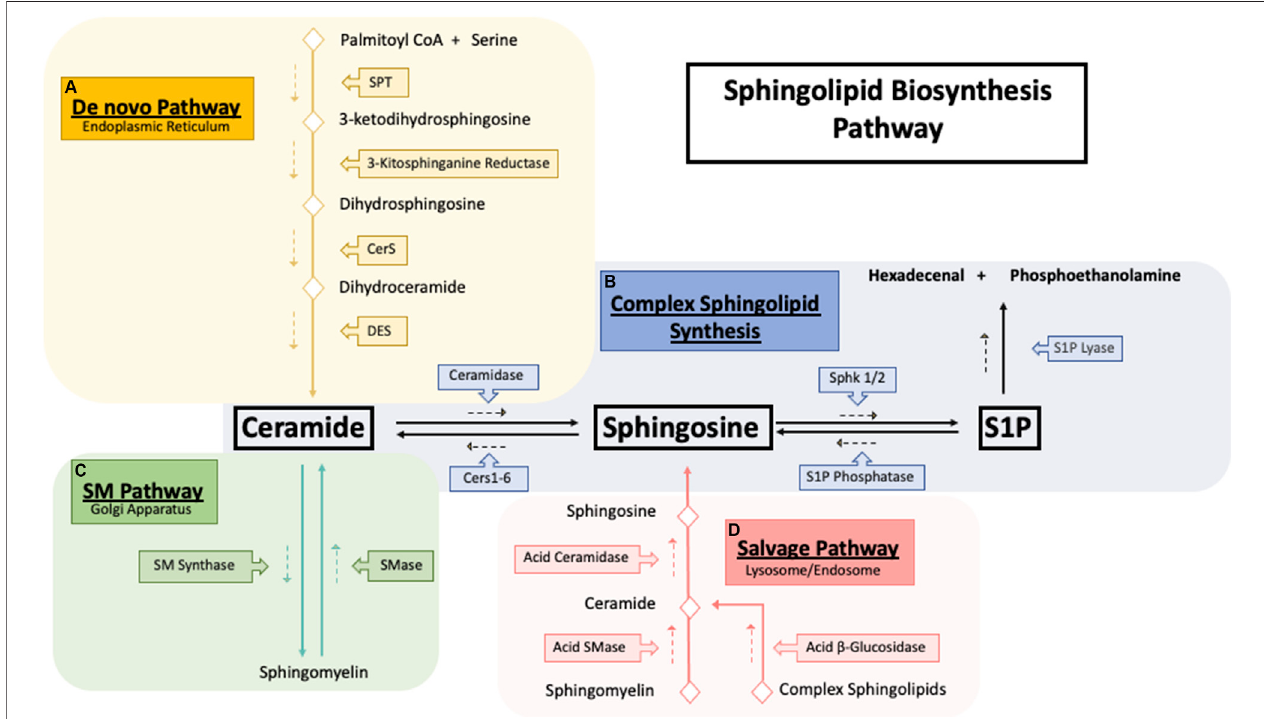
FIGURE1| Sphingolipidsynthesispathways.Sphingolipidbiosynthesispathways. (A) The Denovo sphingolipidpathwayoccursintheendoplasmicreticulum(ER) where the condensation of serine and palmitoyl CoA by serine palmitoyltransferase (SPT) generates the backbone required for the synthesis of ceramide. Ceramide generated by the de novo pathway is then shuttled to the golgi apparatus (B) to be used as building blocks for the synthesis of sphingomyelin and other complex sphingolipids. (C) Exit from the sphingolipid synthesis pathways is initiated through S1P lyase where S1P cleavage results in hexadecenal and phosphoethanolamine which is further metabolized into palmitoyl CoA. (D) Catabolism of sphingolipids occurs in the lysosome where complex sphingolipids is broken down into ceramide which then is ultimately deacylated to sphingosineby acid ceramidase. Sphingosine then exits the lysosome and is synthesized back into ceramide to be further used where